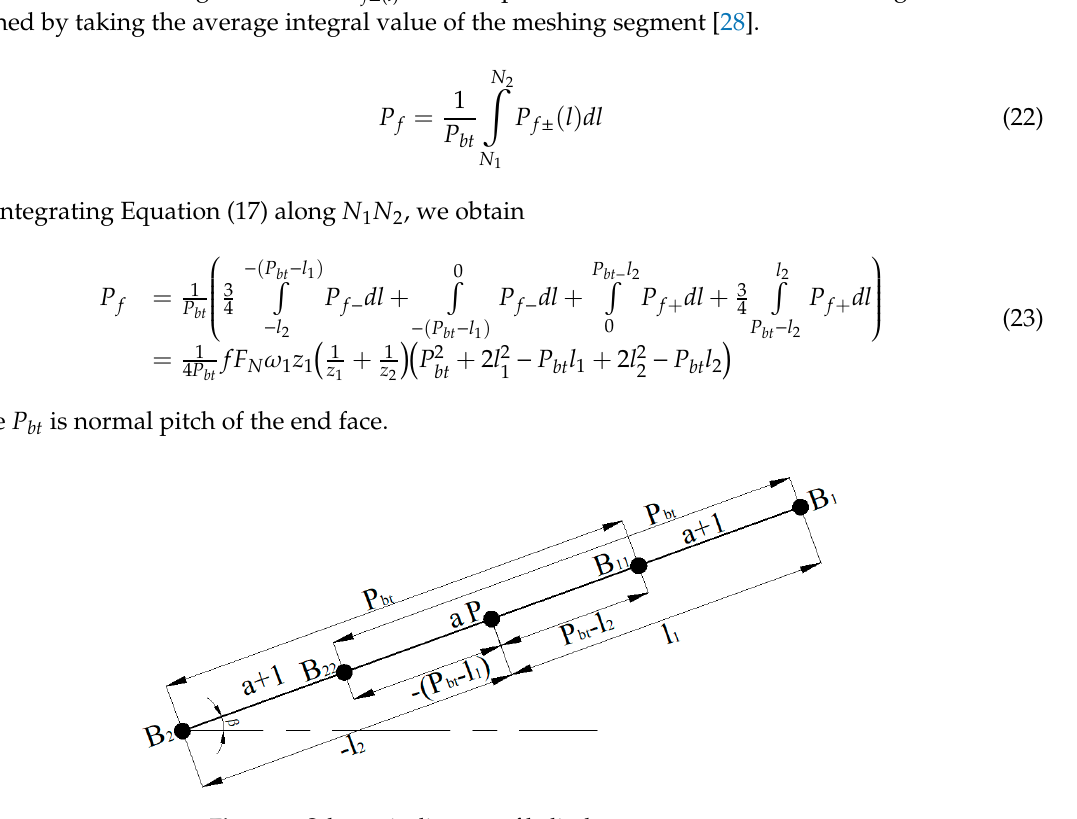
Figure 6. Schematic diagram of helical gear engagement.